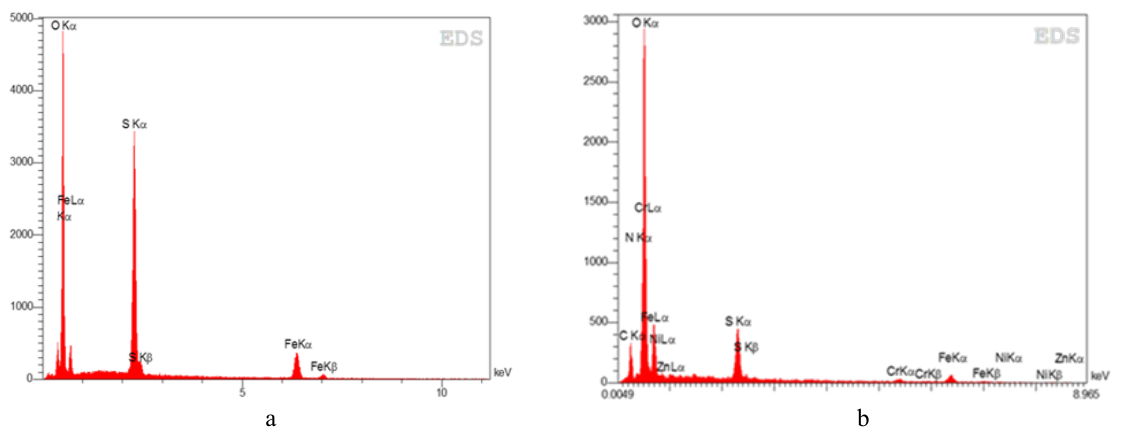
Akar Sh, et al. Removal of Metal Ions Using Ferrous Sulfate. J Adv Environ Health Res. 2021;